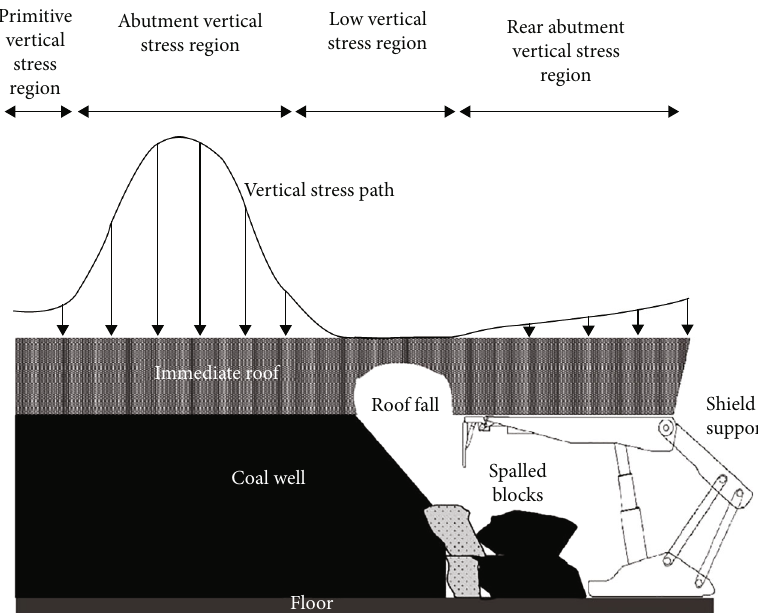
Figure 1: Conceptual diagram of coal wall